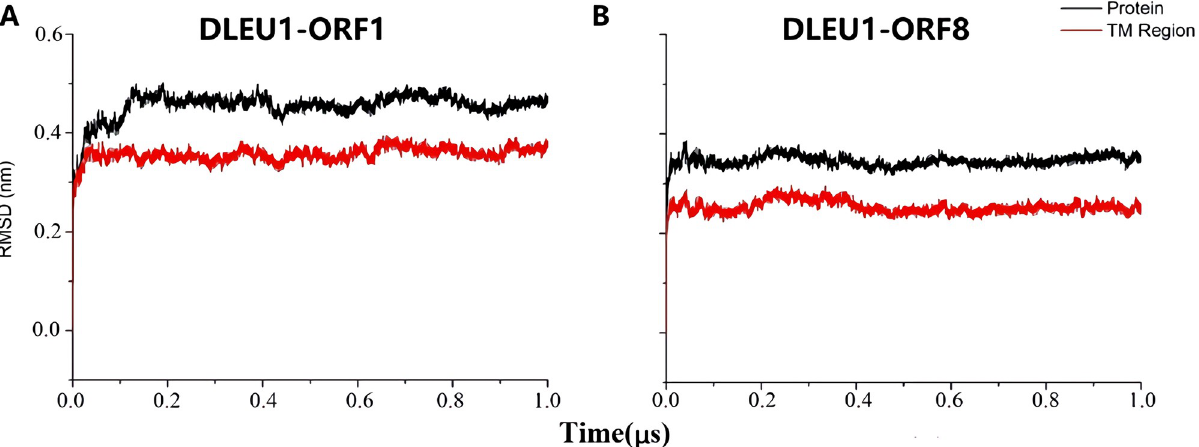
Fig 2. Structural stability of pentameric DLEU1 ORF1 (A) and ORF8 (B) peptides. The black and red solid curves represent the root mean square deviation (RMSD) of the whole protein and TM region, respectively.